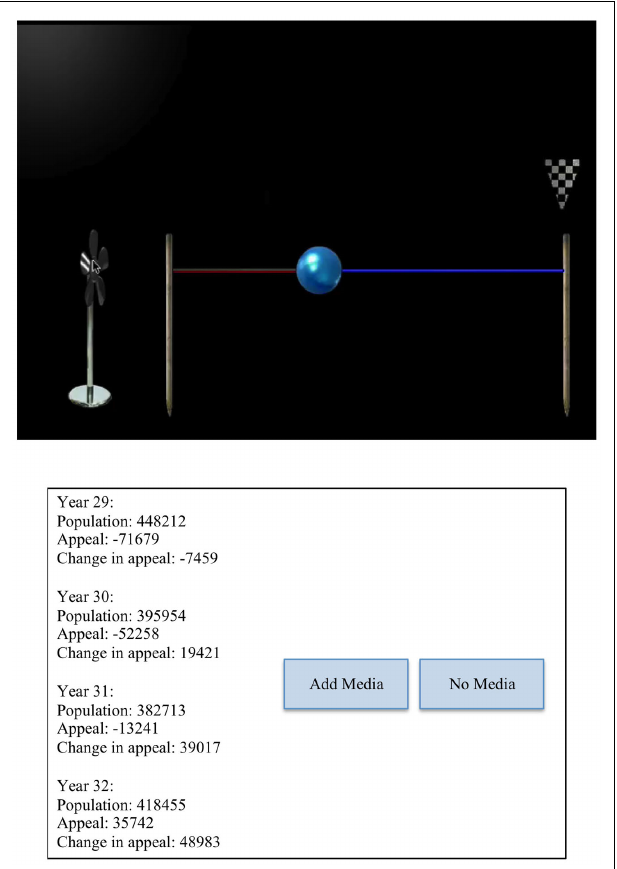
FIGURE 1 |Two superficially dissimilar scenarios instantiating the same principle of reinforcing forces in a resonating system, as studied by Day and Goldstone